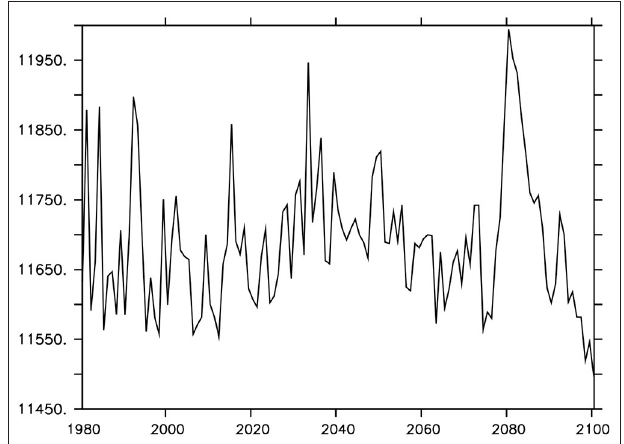
FIGURE 6 | Potential marine aggregate export of MP (in tons per year) to the seafloor, using a MP particle-to-mass conversion from Eriksen et al. (2014) and assuming 1 MP particle is transported by 1 organic